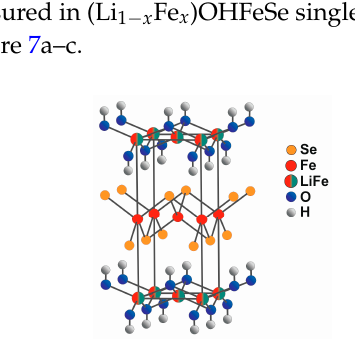
Figure 6. Crystal structure of (Li 1 − x Fe x )OHFeSe [53]. Reprinted with permission from IOP. All rights reserved.